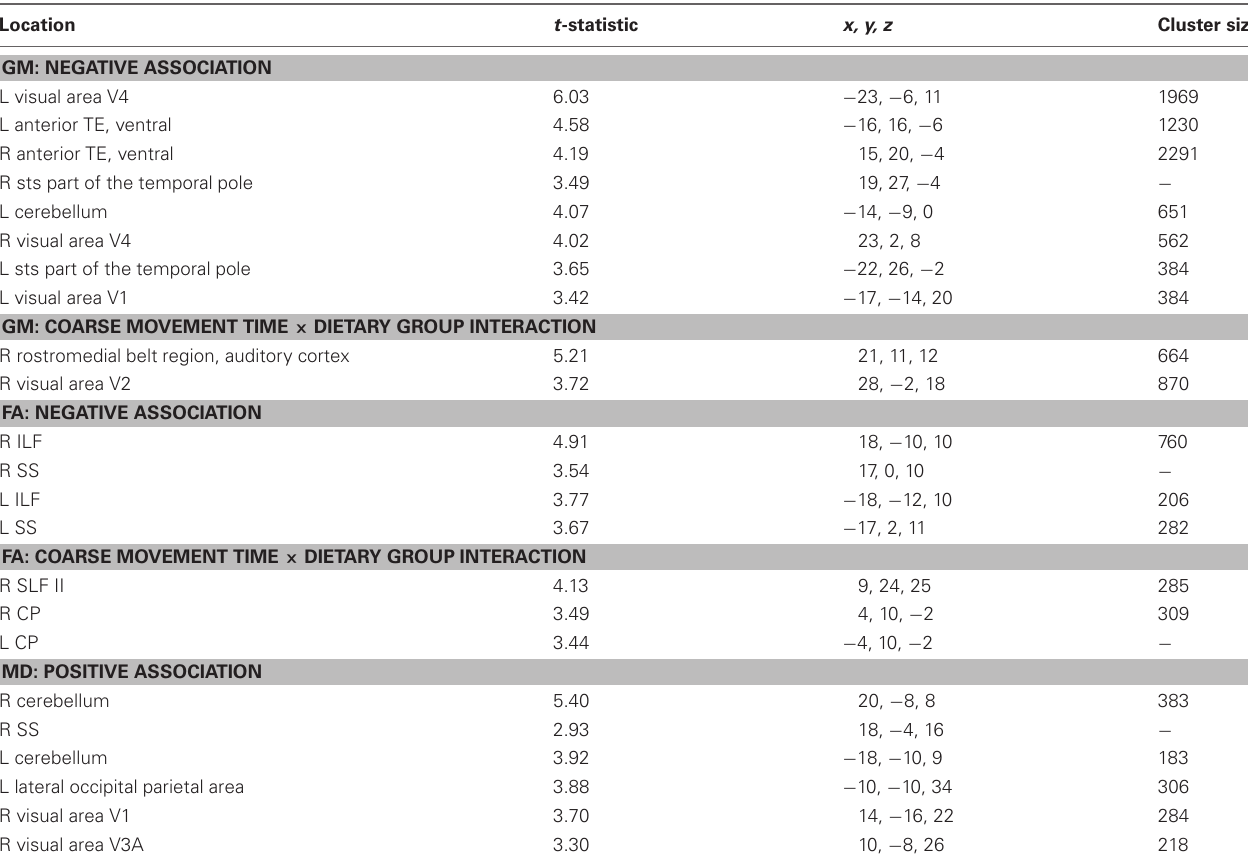
Table A2 | Regions where coarse movement time was significantly correlated with gray matter volume, fractional anisotropy, and mean diffusivity in voxel-wise analyses across subjects and between dietary groups. Location t -statistic x, y, z Cluster